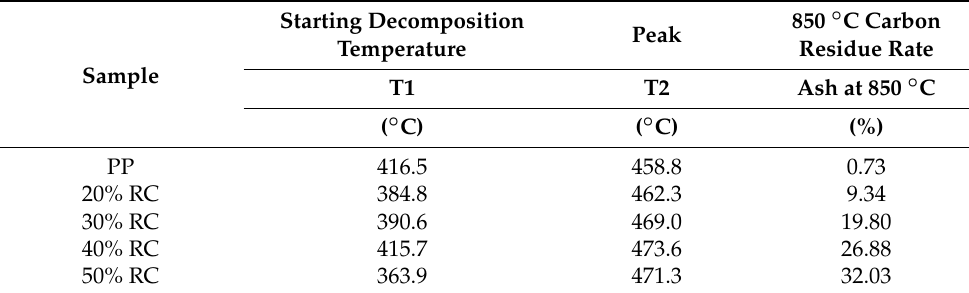
Figure 4. TGA curve and DTG curve of RC/PP Composites. Table 1. Thermal weightlessness of PP and RC/PP composites.